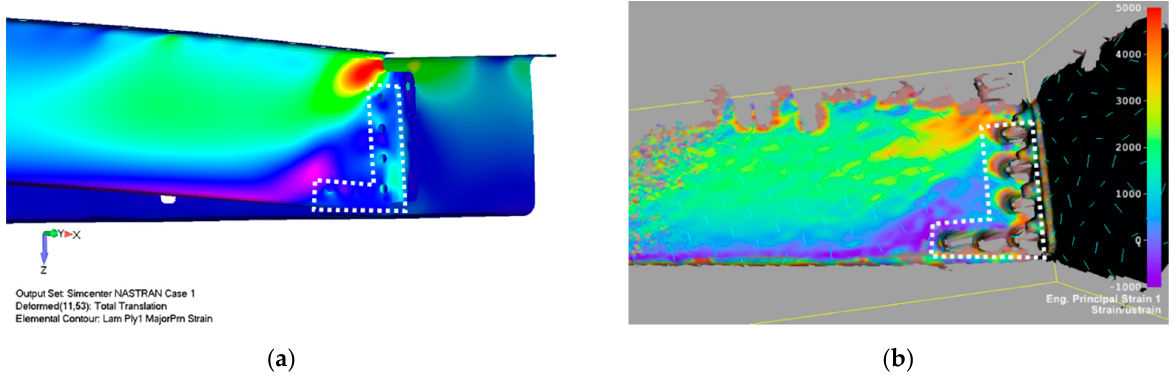
Figure 23. Comparison of principal strain contour map between FE simulation (a) and DIC measurement (b) before fatigue load for LL level. The dotted white line illustrates the area corresponding to the low resolution of the DIC measurement due to sharp lines or curved surfaces.